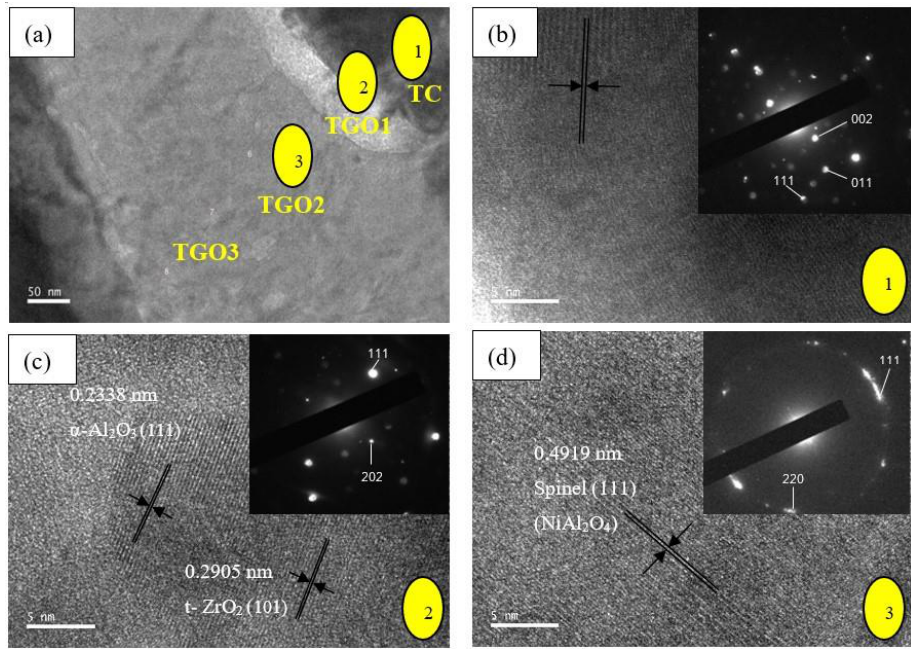
Figure 16. TEM micrograph of ( a ) TGO cross-sectional of sample H1080c with interplanar distance and diffraction patterns at ( b ) topcoat, ( c ) TGO1, and ( d ) TGO2.